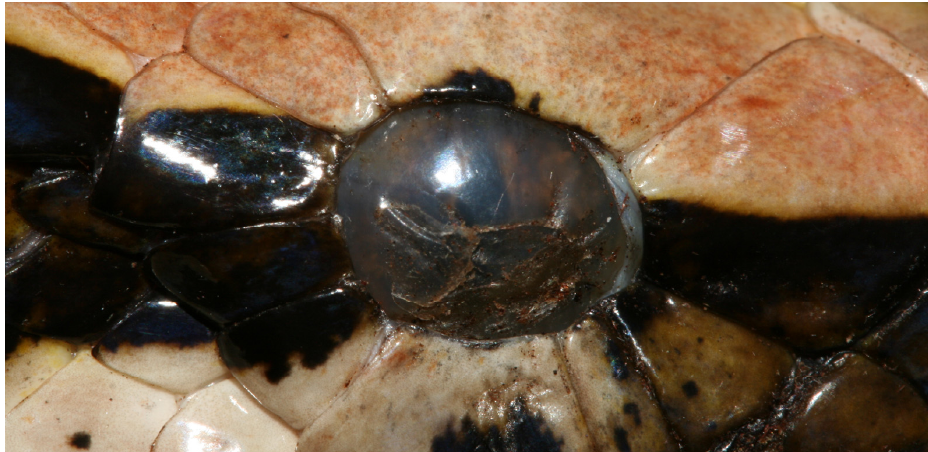
Figure 10. Appearance of the spectacle in a Burmese python ( Python bivittatus ) following a first shed after performing a partial spectaculectomy.